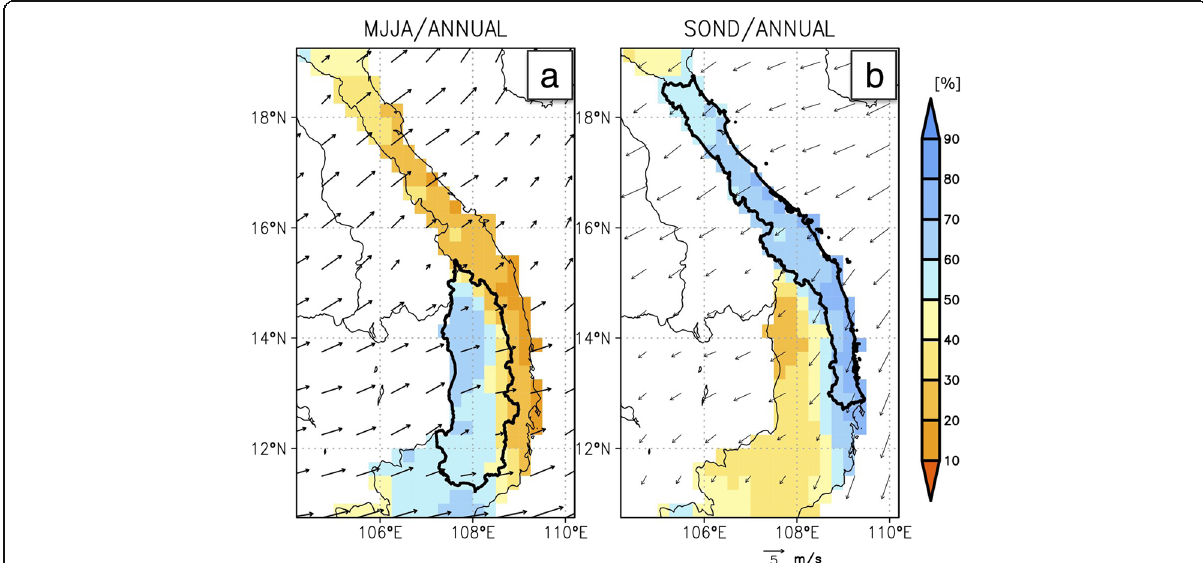
Fig. 2 Spatial patterns of a MJJA and b SOND total rainfall contribution in percentage to annual rainfall over Central Vietnam averaged for 2001 – 2010, derived from the VnGP data. Vectors show horizontal wind fields at 925 hPa averaged for the corresponding months and years, derived from ERA-Interim reanalysis data. The VCH and the VCC are surrounded by black thick lines in a MJJA and b SOND patterns, respectively